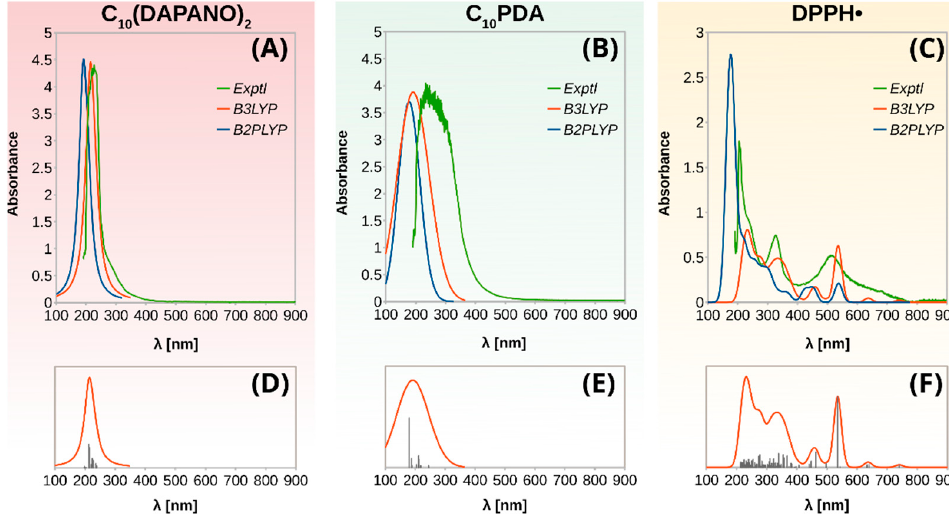
Figure 4. Experimental and theoretically computed UV-vis absorption spectra of C 10 (DAPANO) 2 ( A ), C 10 PDA ( B ), and DPPH• ( C ). The predicted spectra were simulated by associating a single Gaussian (for C 10 PDA and DPPH • ) or Lorentzian [for C 10 (DAPANO) 2 ] to each computed transition. The transitions computed at the B3LYP theory level are shown in ( D – F ) for C 10 (DAPANO) 2 , C 10 PDA, and DPPH•, respectively.